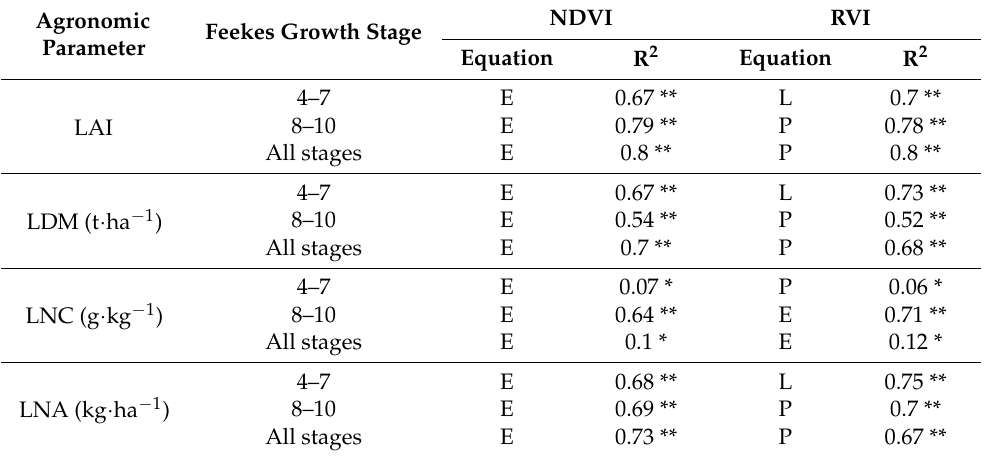
Table 4. Coefficient of determination between NDVI, RVI and wheat agronomic parameters at different stages in experimental fields across site-years.